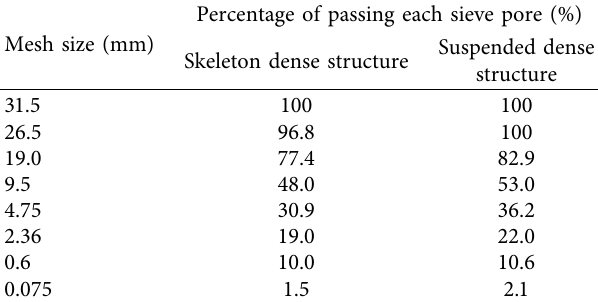
Table 1: Gradation design table of CSM. Mesh size